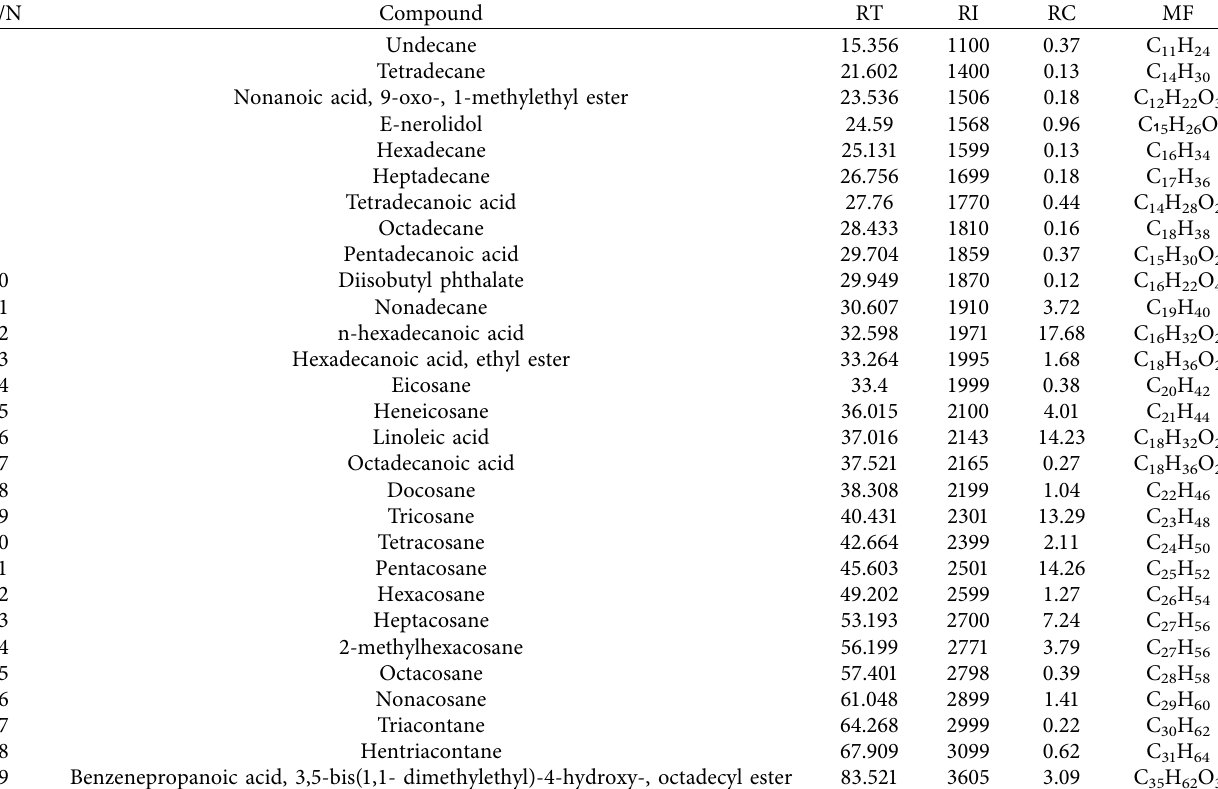
Table 1: Compound detected in the GC-MS analysis of the essential oil from fresh S. rugosoannulata fruiting bodies. S/N Compound RT RI